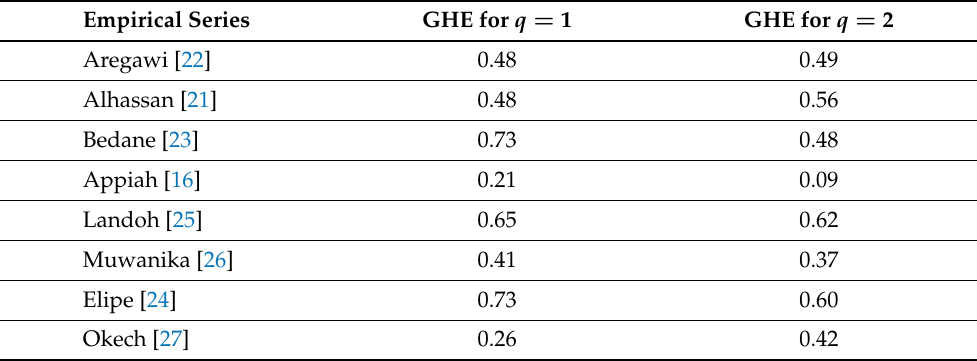
Table A1. Table with the general Hurst exponent (GHE) computed, using Equation (A2), for the entire time series and for q = 1 and q = 2 of the eight empirical time series. Empirical Series GHE for q = 1 GHE for q = 2 Aregawi [22] 0.48 0.49 Alhassan [21] 0.48 0.56 Bedane [23] 0.73 0.48 0.21